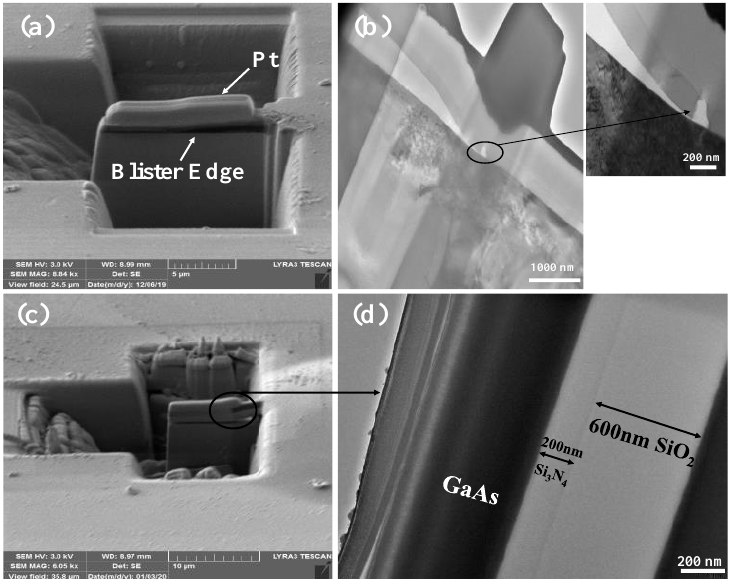
Figure 5. Cross-sectional diagram of blister in Samples C and D. ( a ) Schematic diagram of blister edge cut by FIB (focused ion beam) in Sample C; ( b ) Cross-sectional diagram of blister in sample C; ( c ) Schematic diagram of blister edge cut by FIB (focused ion beam) in Sample D; ( d ) Cross-sectional diagram of blister in sample D.